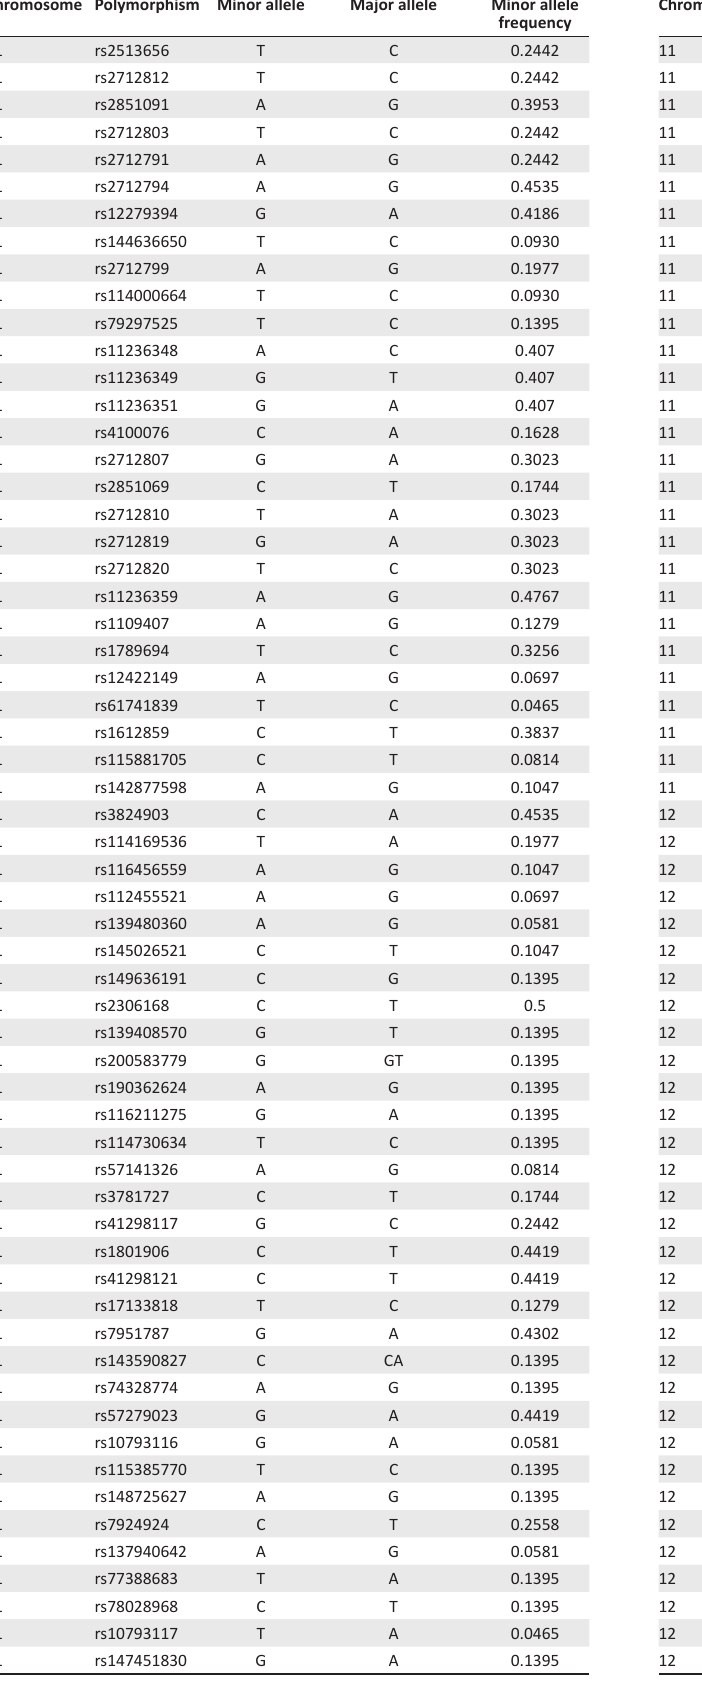
Table 1-A1 continues on the next page →Table 1-A1 continues in the next column